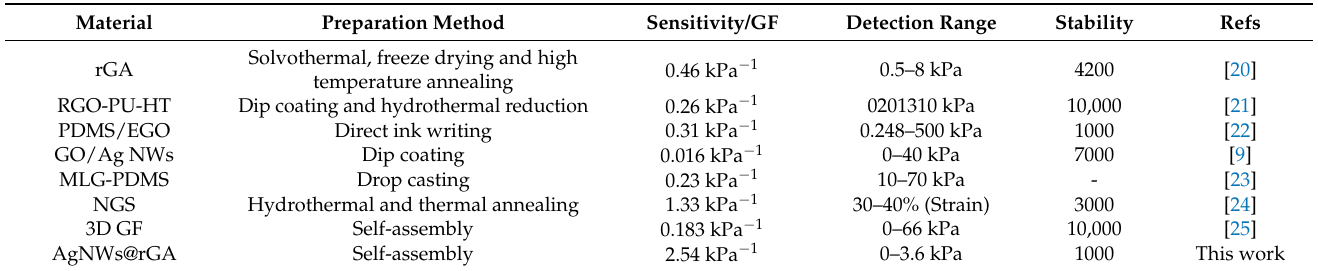
Figure 3. ( a ) Schematic working illustration of the self-powered sensor. ( b ) ∆ I/I 0 versus time plots under different pressure of 0–3.6 kPa. ( c ) Repeated measurements of ∆ I/I 0 of self-powering pressure sensor under different pressures of 0.8, 1.6, 2.4, and 3.2 kPa. ( d ) ∆ I/I 0 of the sensor toward stepped pressure of 0–3.6 kPa. ( e ) ∆ I/I 0 with the applied pressure, slope represents sensitivity S. ( f ) Working mechanism of piezoionic self-powering sensor. Table 1. Summary of the graphene-based pressure sensors compared with our